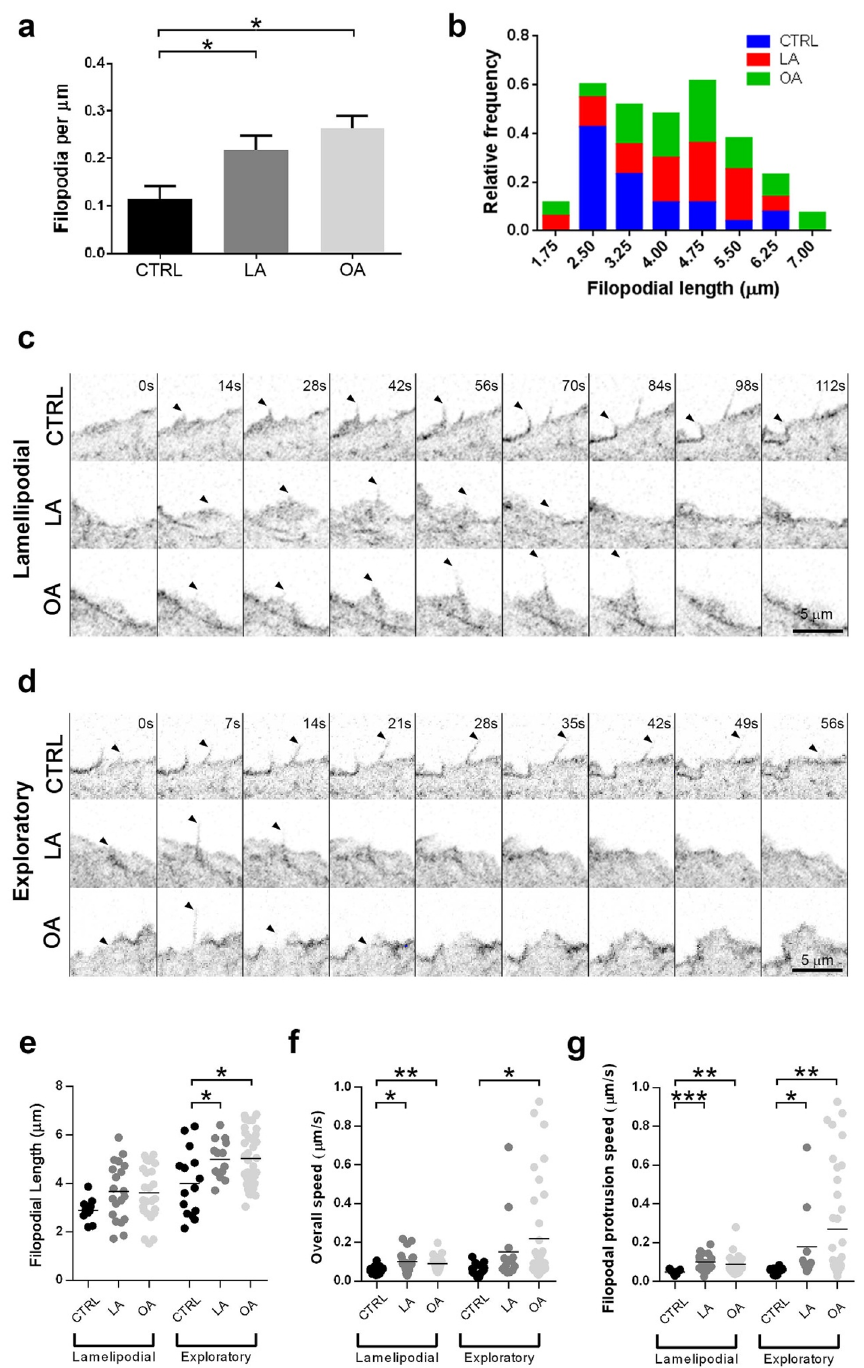
Figure 3. OA and LA altered actin-based structures at the leading during migration. ( a ) Mean number of filopodia per μm at the leading edge in Control (black), LA (gray) and OA (light gray) treated cells, significance tested with Kruskal–Wallis test and Dunn’s multiple comparisons, n = 15–45 per subgroup in 2 independent experiments. ( b ) A histogram shows the overall change in distribution of filopodial length in control (blue), LA (red) and OA (green) cells. ( c , d ) Still images from a time-lapse videomicroscopy depicting lamellipodicfilopodia ( c ) and exploratory filopodia ( d ) in SKOV-3 LifeAct-GFP cells for the control group and cells treated with LA or OA. The time of each frame is shown on the top of the control panel. The arrowhead points out a filopodia that completes its protrusion cycle within the shown timeframe. Scale bar 5 μm. ( e ) Filopodial length comparison among treatments. ( f ) Filopodial speed reflects the time (expressed in μm/s) that the filopodia takes to protrude and retract. ( g ) Filopodia protrusion speed reflects the time (expressed in μm/s) that the filopodia took to protrude. Data presented as scatter dot plots with a line at the mean value, significance tested with Kruskal– Wallis test and Dunn’s multiple comparisons, n = 15–45 per subgroup, 2 independent experiments. Asterisks represent statistical significance (*p < 0.05, **p < 0.01, ***p <